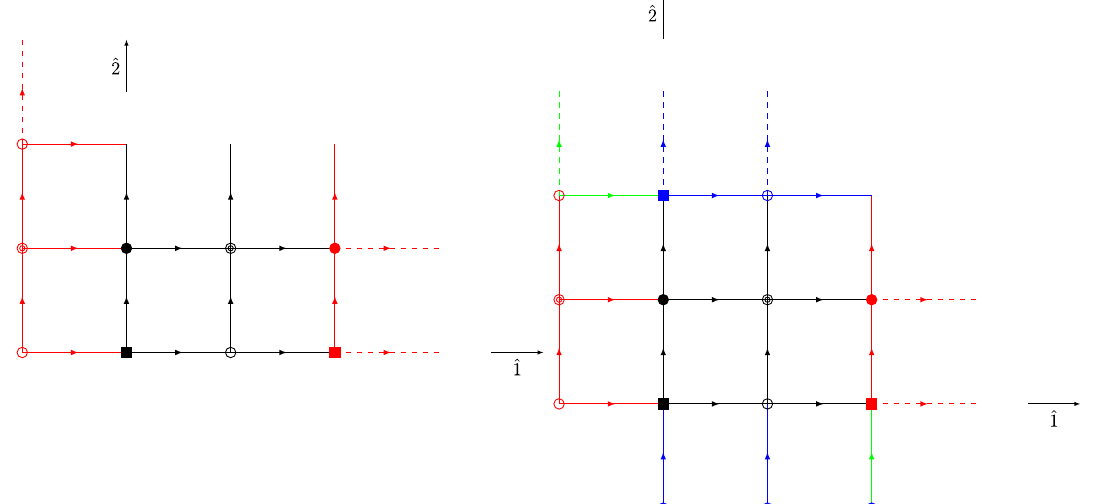
Fig. 15 Sketch of the PRlgt auxiliary links in a plane of a 2 × 2 lat- tice. Physical links are in black and sites identified by the same symbol represent the same physical site. Dashed lines highlight links that are allocated but do not participate in the update. In the left panel direction ˆ 1 is twisted, ˆ 2 is not: in red there are the auxiliary sites (two forward, three backward) and the red links beginning there correspond to phys-